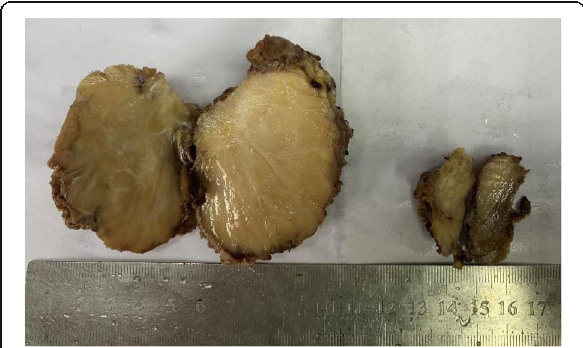
Fig. 2 Gross features. The specimen detected was a block of tissues